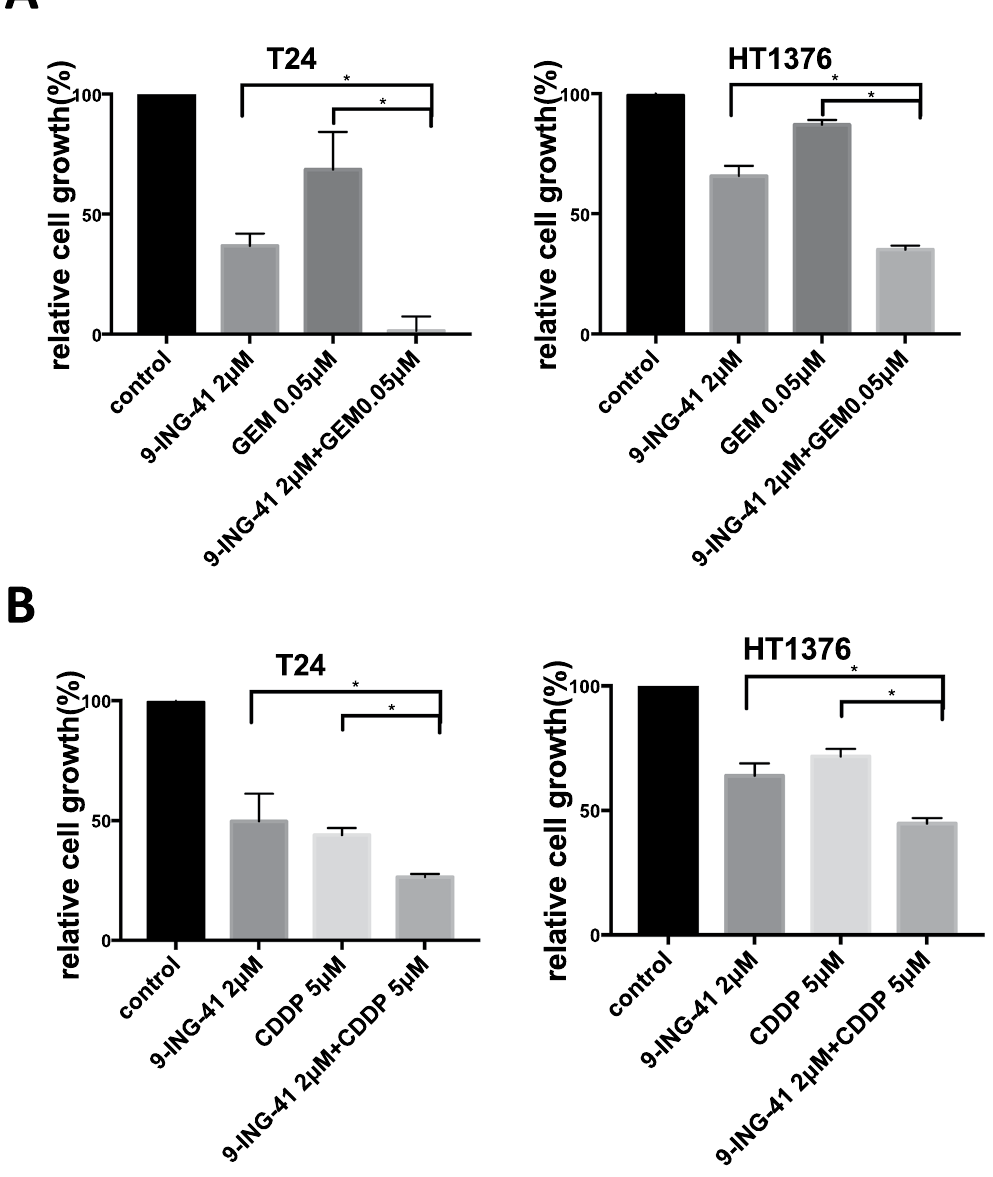
Figure 4. Pharmacological inhibition of GSK-3 β with 9-ING-41 potentiates the effect of anticancer therapeutics in bladder cancer cells. ( A,B ) Relative cell growth was measured by MTS assay in bladder cancer cell lines T24 and HT1376 treated with 9-ING-41 in combination with gemcitabine ( A ) and cisplatin ( B ) for 3 hours as indicated. After the treatment, drugs were replaced with fresh culture medium and relative cell growth was measured by MTS assay after 72 hours. Columns, mean; bars, SD. * P < 0.05 by one-way ANOVA with Tukey post-hoc